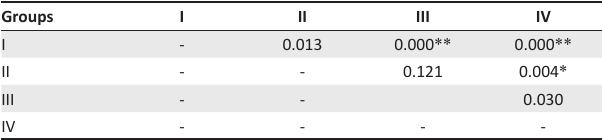
TABLE 2: Mann Whitney U test findings in complex pretend play Free Play scenario .